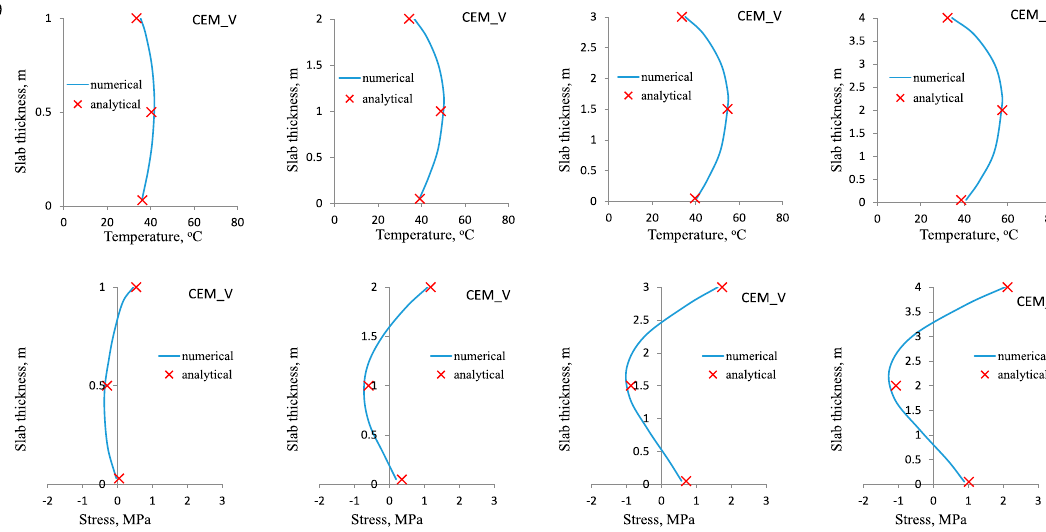
Figure 7. Numerical and analytical results for slabs made of concrete with cement CEM V: ( a ) Temperature distribution at the slab thickness, ( b ) total stress distribution at the slab thickness.